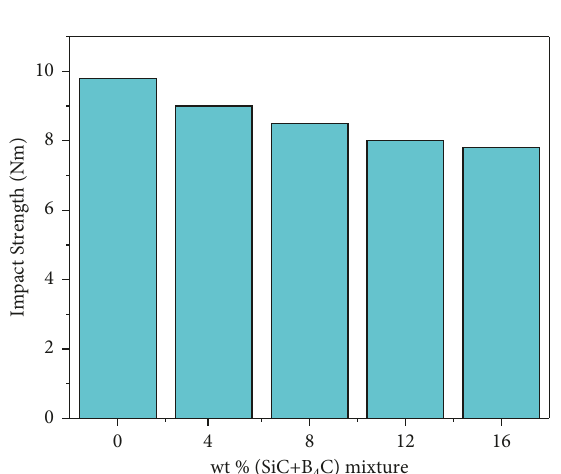
Figure 8: Impact strength on variant wt% of (SiC+B